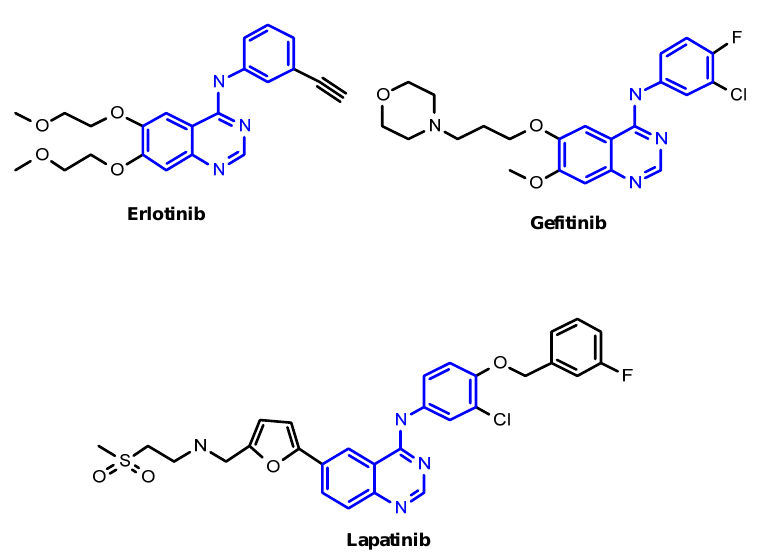
Figure 3. The structure of erolotinib, gefitinib and